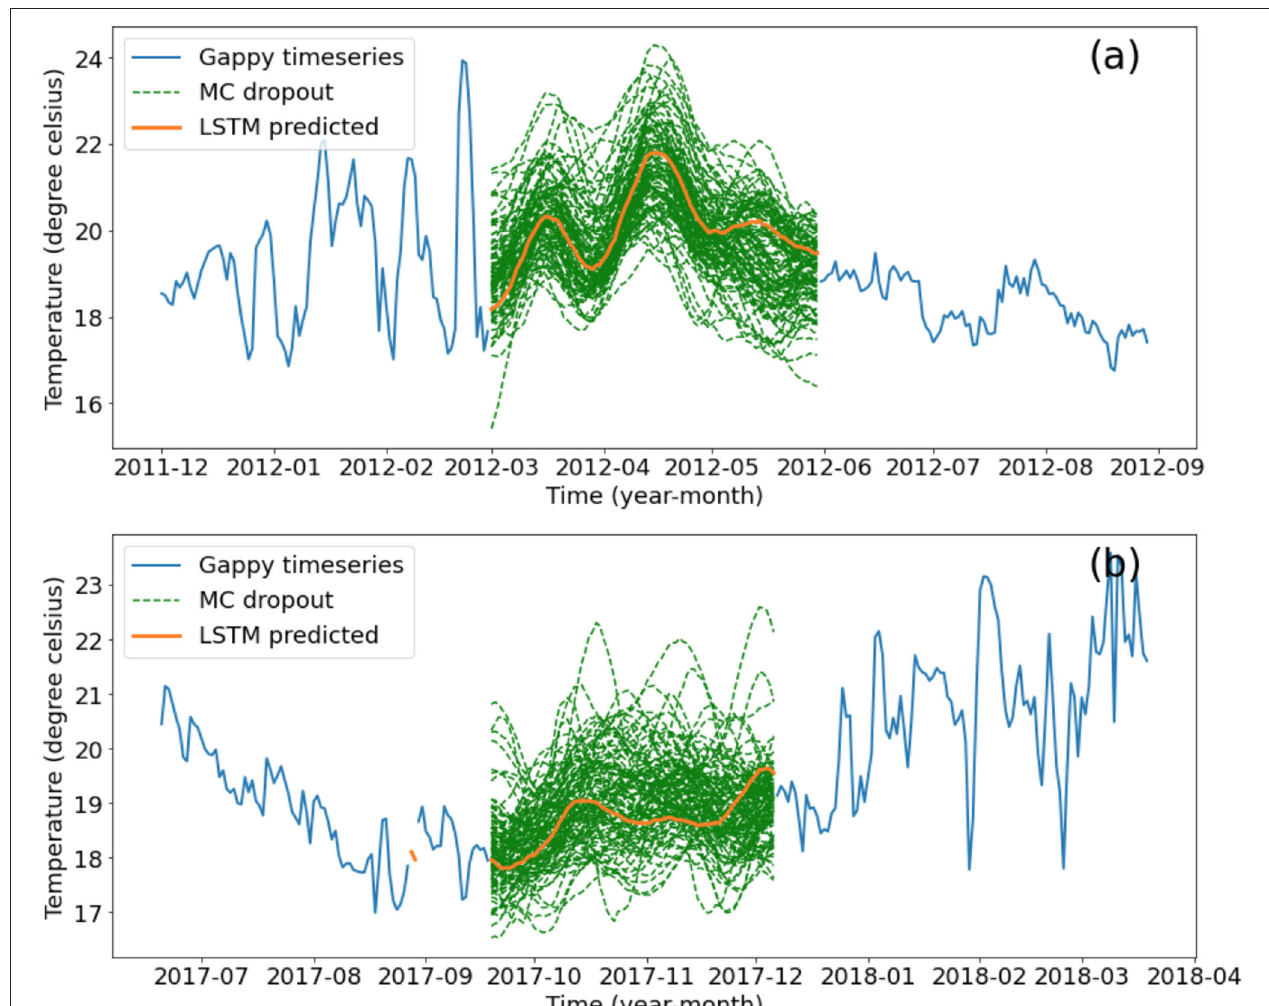
FIGURE 11 | Gap-filling of the (a) 91 day gap and (b) 79 day gap based on the final LSTM model (orange) and the five models with dropout layers (where 40% of nodes in each of the three layers are randomly switched off in the training process) in green, representing model uncertainty. Original timeseries is shown in blue. Units: ◦